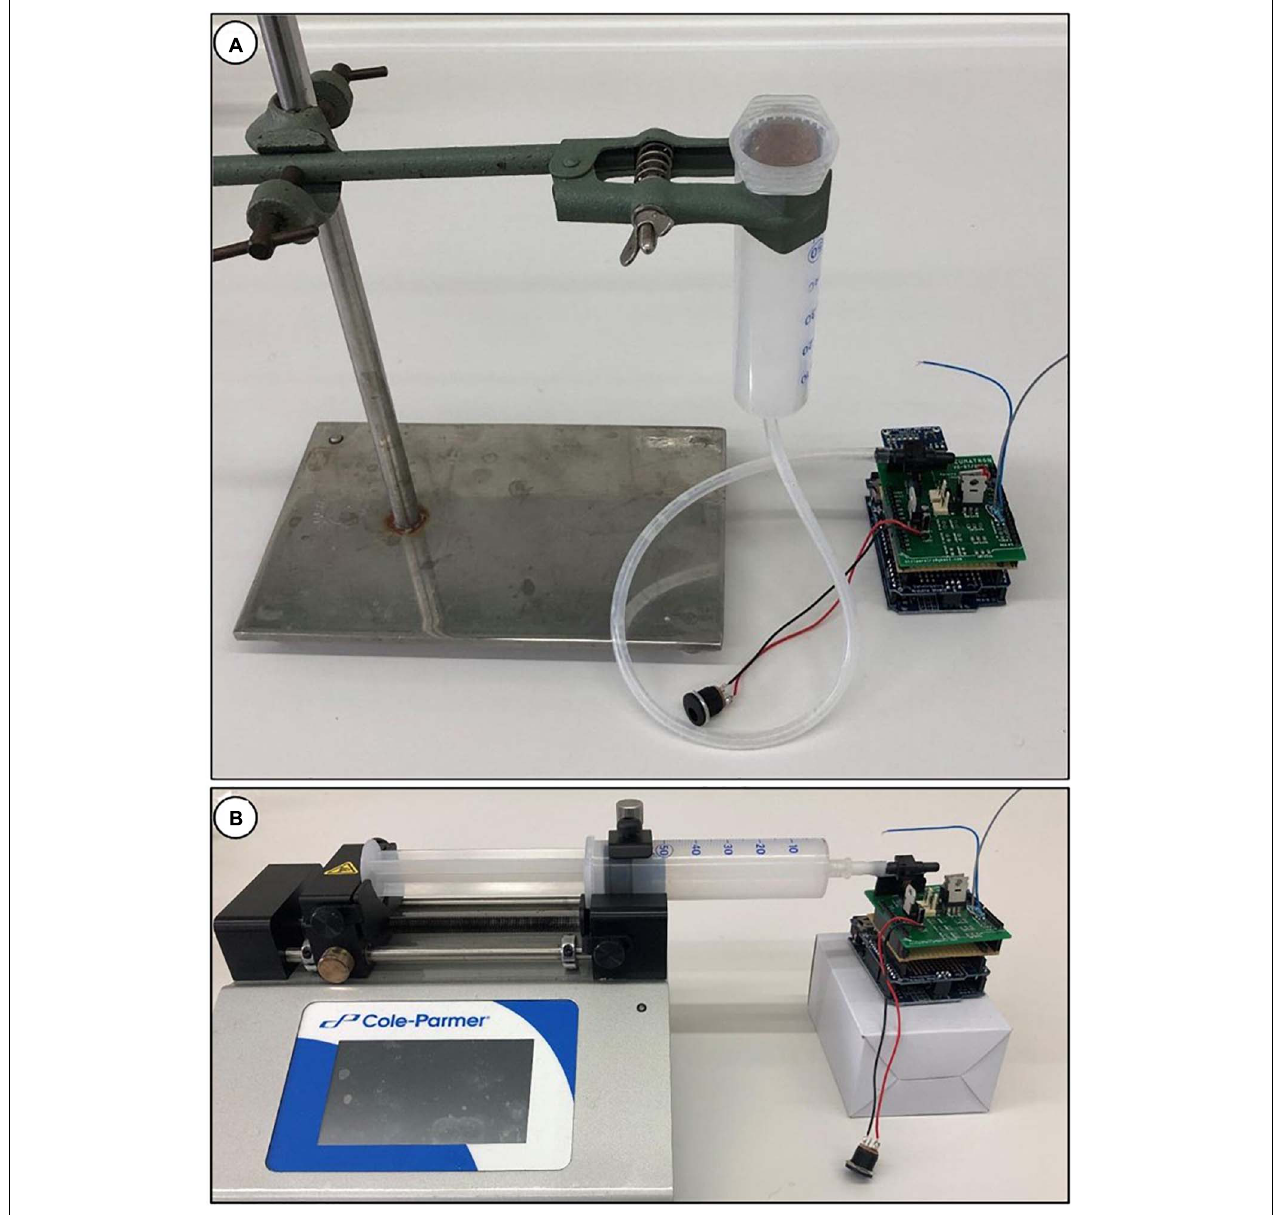
FIGURE 4 | Calibration of the pressure sensor in a Pneumatron device using a water column (A) , with a water-filled syringe and tubing; the pressure is estimated by measuring the height of the water column (from the pressure sensor to the free surface of the liquid). Calibration of a pressure sensor can also be done using a syringe pump (B)